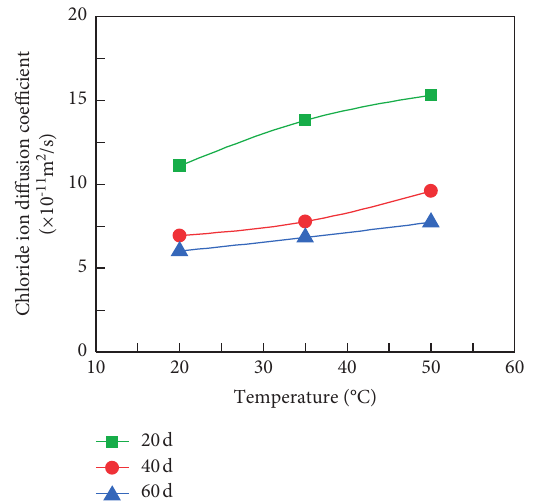
Figure 4: Chloride diffusion coefficient with different temperatures and penetration time.